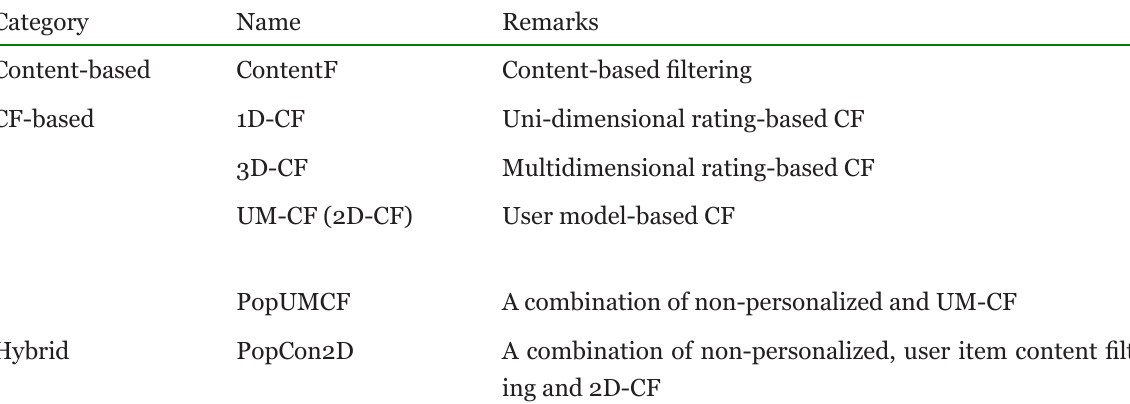
Table 3 A Summary of the Various Recommendation Techniques